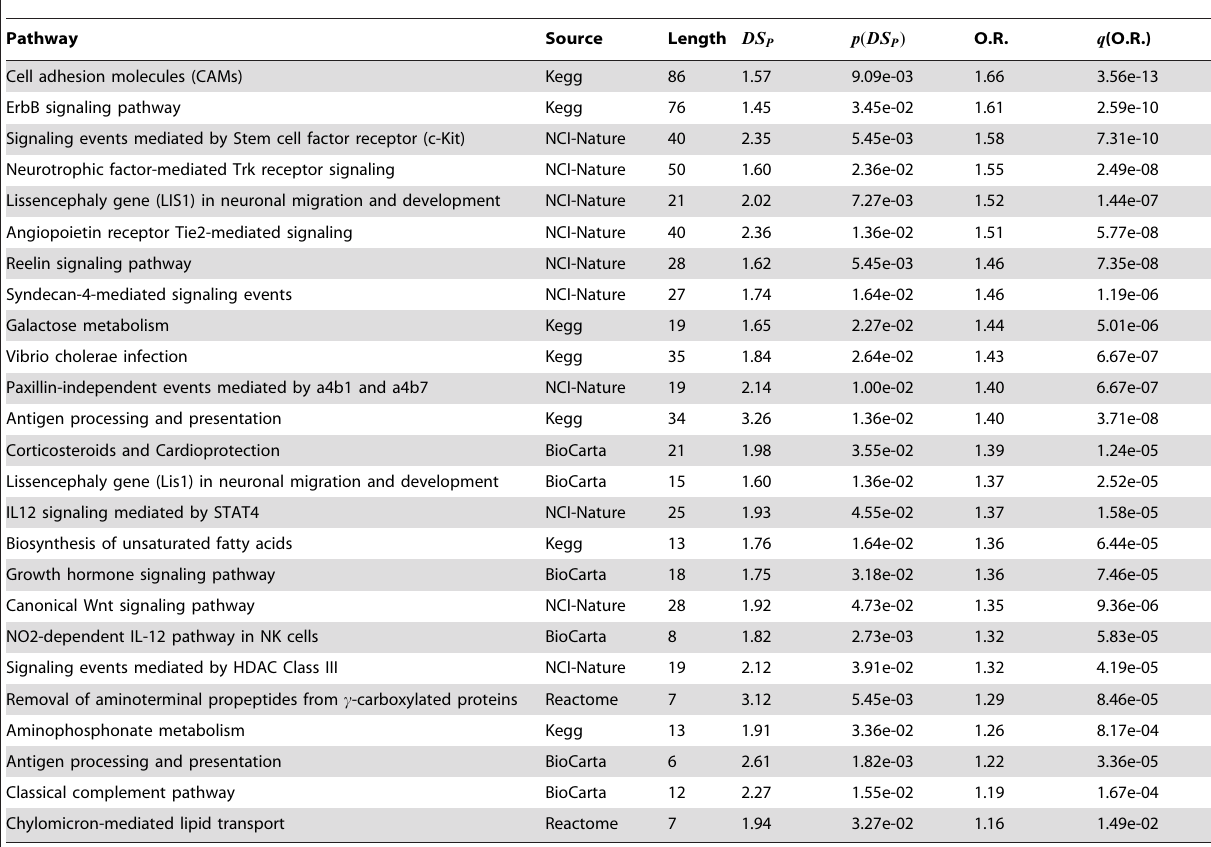
Table 3. PID pathways with significant DS P in the liver cancer GWAS.